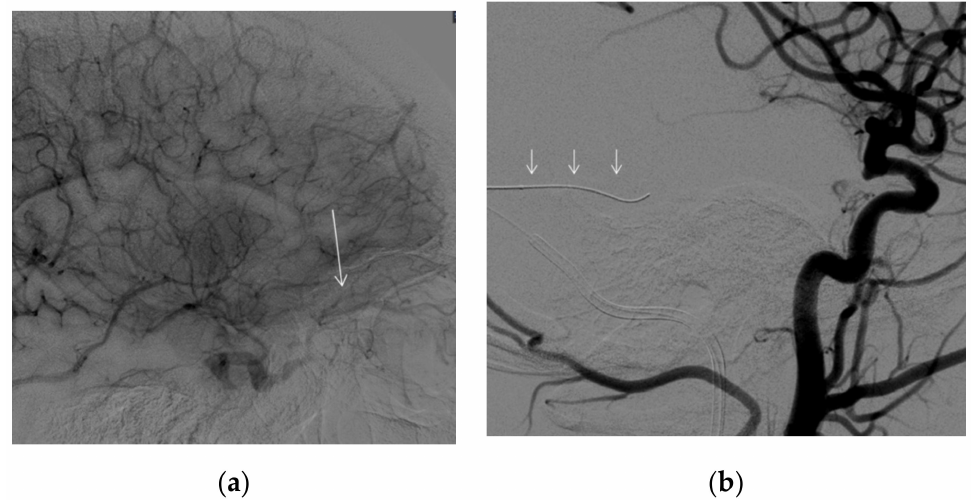
Figure 4. DSA. Embolization procedure. Left common carotid artery, lateral view. ( a ) Left inferior (arrow) and ( b ) left superior petrosal sinus (small arrows) catheterization. No access to the venous pouch of the fistula could be found.